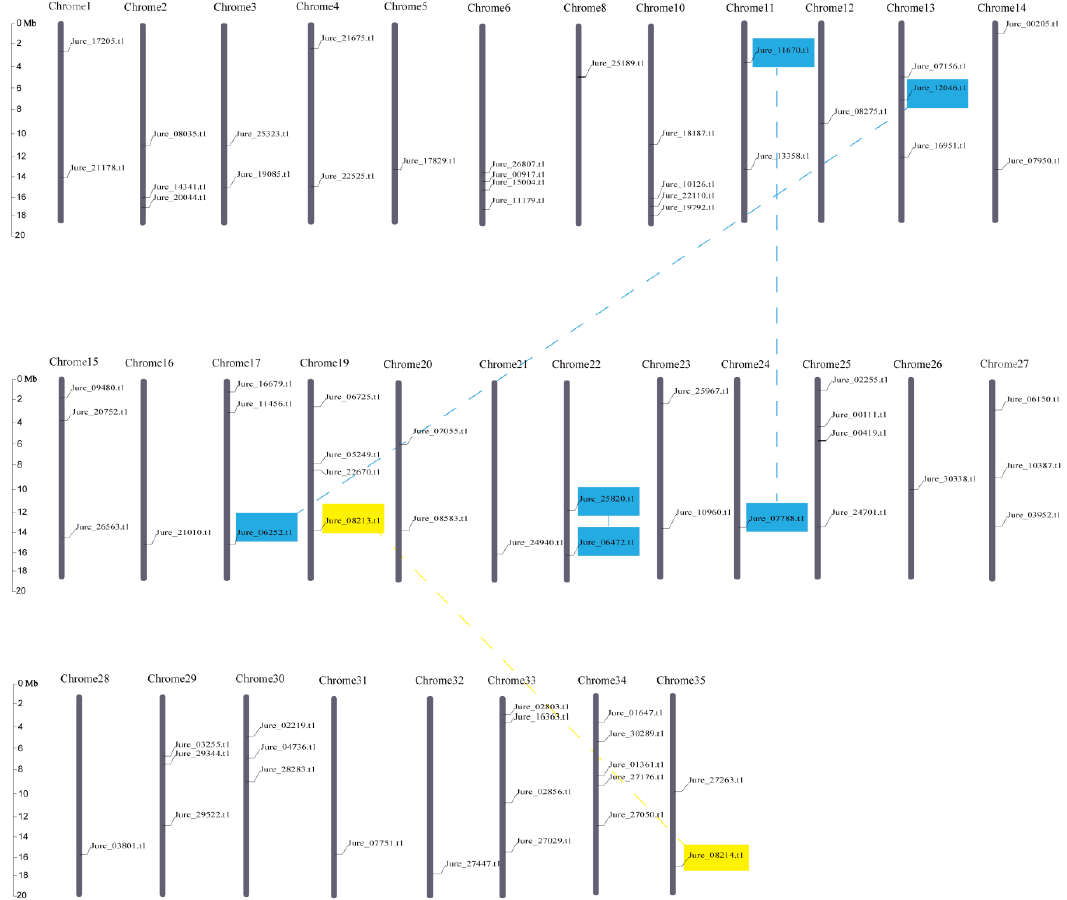
Figure 2. Chromosomal locations in common walnut of F-box genes on 31 pseudo-chromosomes. The pseudo-chromosome name is at the top of each bar. The scale of the pseudo-chromosome is millions of base pairs (Mb). The blue box represents the gene pairs of the F-box gene family of segmental duplication. The orange box represents the gene pairs of the F-box gene family of tandem duplication.